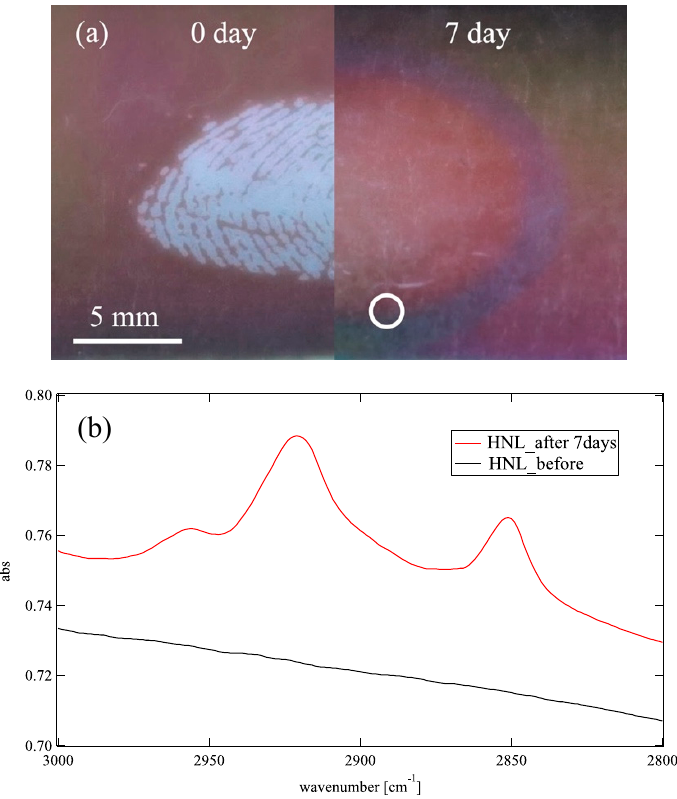
Figure 4. A long-time change of the fingerprint on HNL. A spreading ring appeared around the fingerprint as shown in ( a ). The IR spectra measured at the ring indicated in ( a ) detected the fatty acid alkyl group detected in Figure 3 as shown in ( b ).